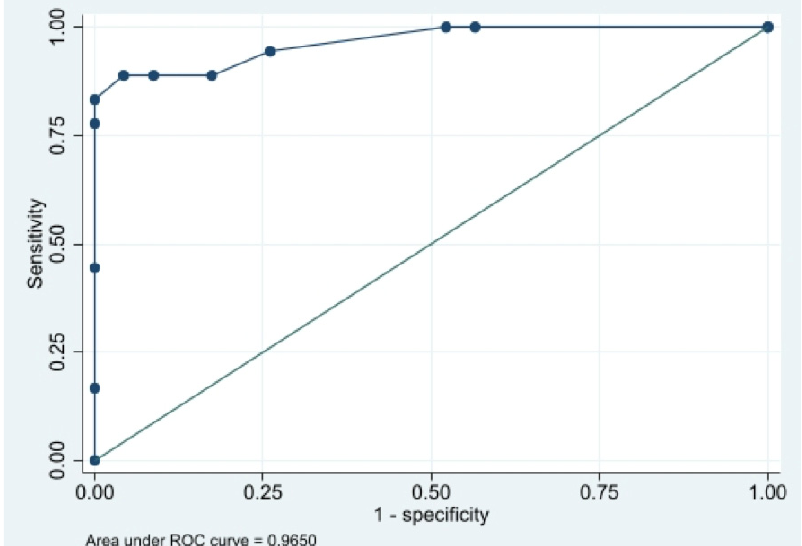
Figure 2. ROC curve of prediction model.